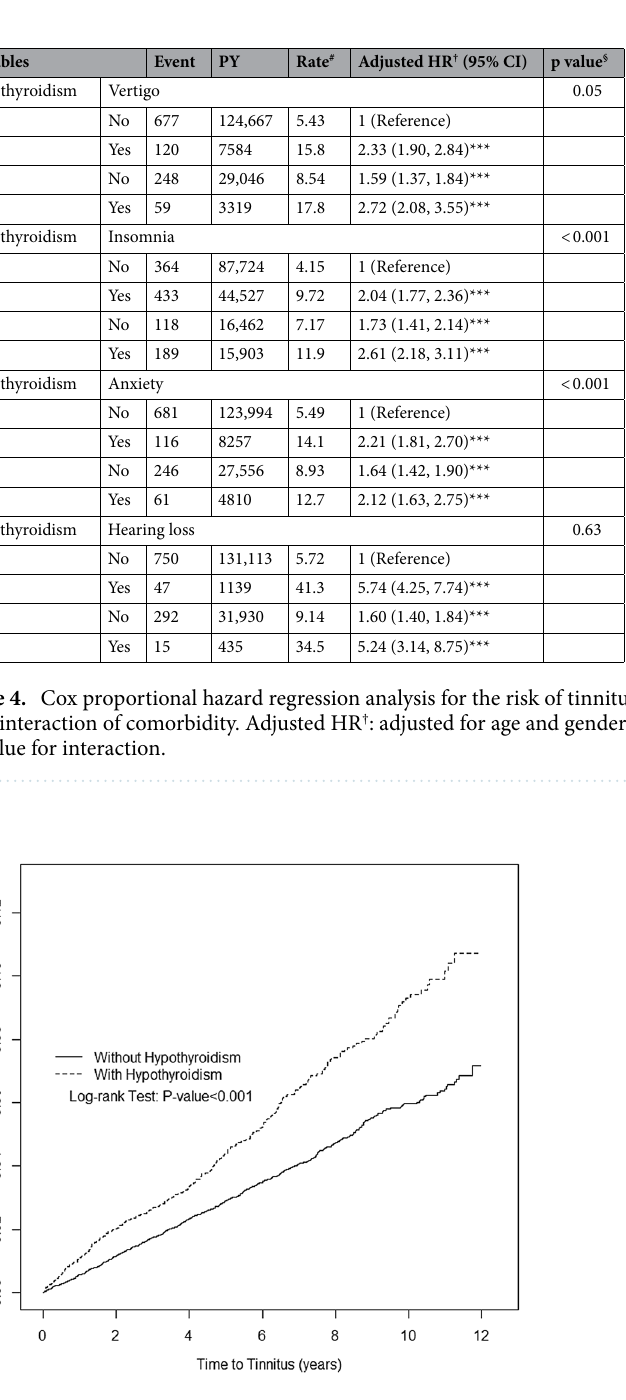
Figure 1. Cumulative incidence of Tinnitus for patients with (dashed line) or without (solid line)